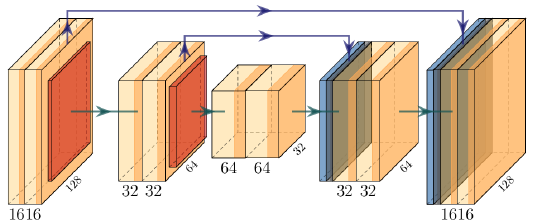
Figure 6. Illustration of the CNN portion of the CVNN. For a 2D CVNN-UNet it is a 2D U-Net with 2 blocks, while for a 3D CVNN-UNet it is a 3D U-Net with 2